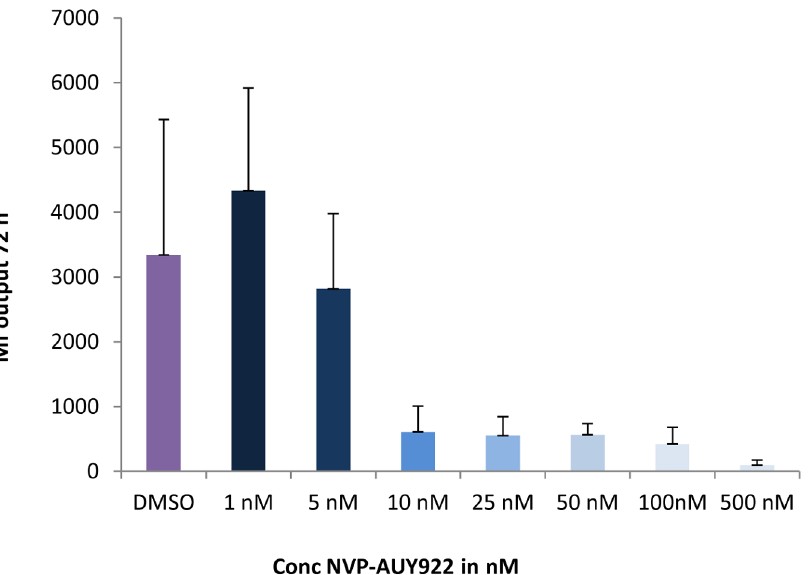
Figure 2. NVP-AUY922 significantly reduces Mf output from female worms at 10 nM. Graph shows mean ( 6 SD) Mf output from groups of six female B. pahangi worms after 72 h exposure to NVP-AUY922 at 500, 100, 50, 25 10, 5 and 1 nM compared to DMSO control. Mf output is significantly different from control at all concentrations to 10 nM NVP-AUY922 (P # 0.0087). Results shown are representative of three experiments. In this experiment, cultures were continued for a further 3 days and Mf counted again. At this time point (a total of 6 days exposure to drug), Mf output was significantly different from controls at 5 nM NVP-AUY922 (P=0.0043) but not at 1 nM.